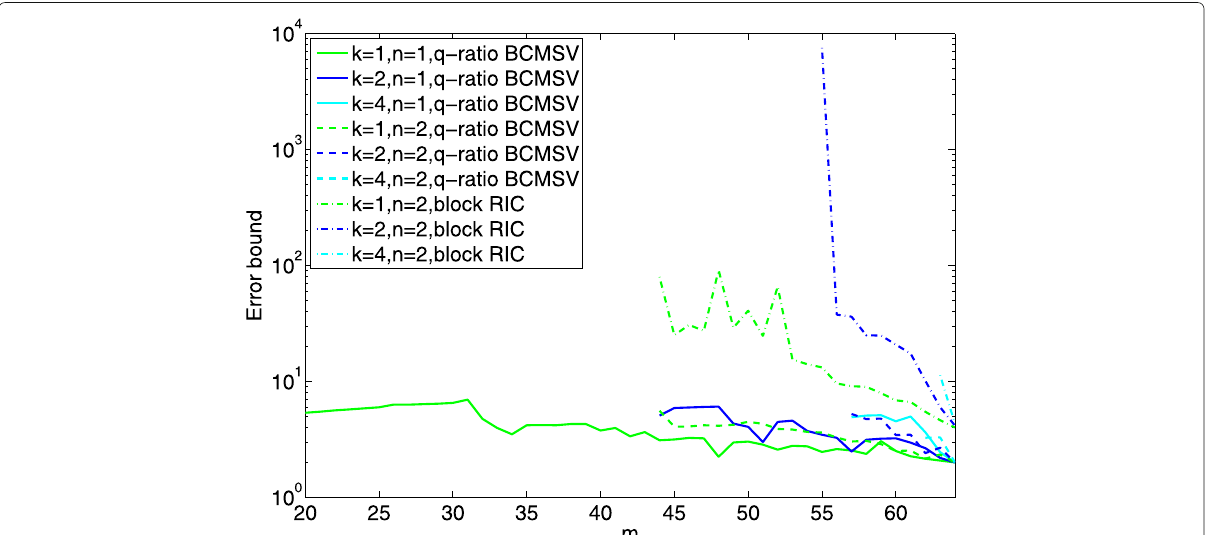
Fig. 2 The q -ratio BCMSV-based bounds and the block RIC-based bounds for Hadamard sub-matrices with N = 64, k = 1,2,4, n = 1,2, and q = 1.8